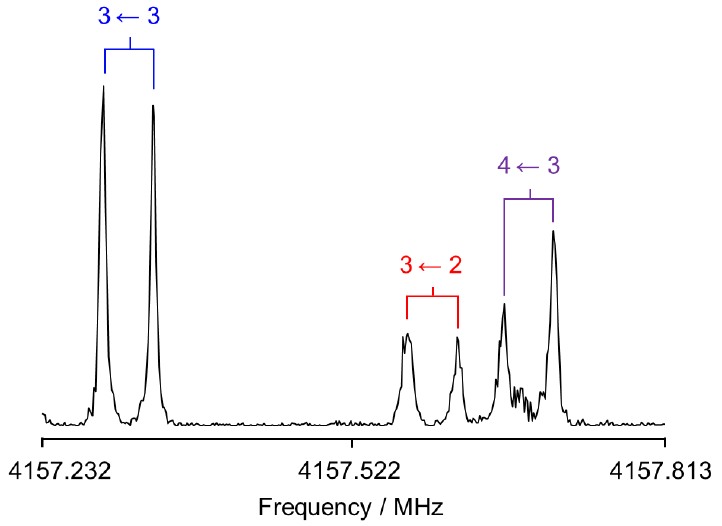
Figure 5. A typical resonator-based FTMW spectrum of the a -type transition 3 1,3 ← 2 1,2 showing its 14 N nuclear quadrupole hyperfine structure. Each transition is split into two components due to the Doppler effect. The line was polarized at 4157.313 MHz, and 241 free induction decays were co-added.